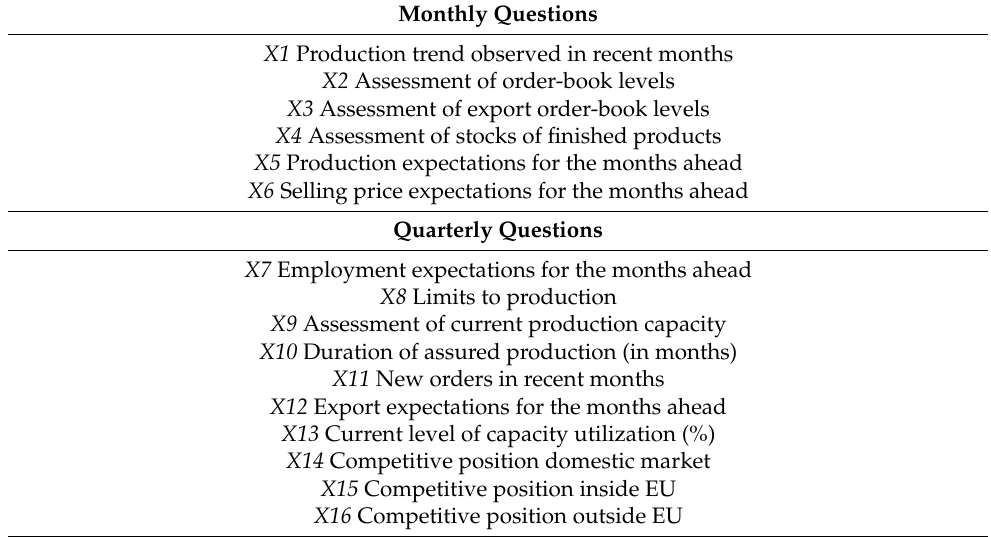
Table 1. Survey indicators—industry survey.